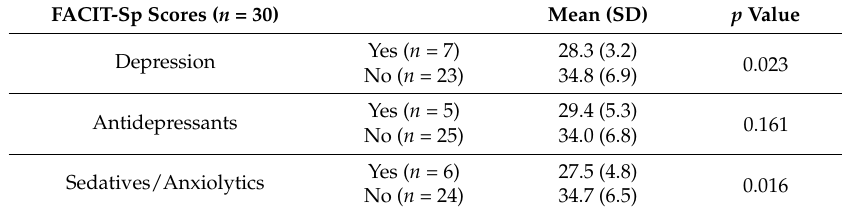
Table 3. FACIT-Sp scale scores related to depression diagnosis and the use of psychotropic medication.